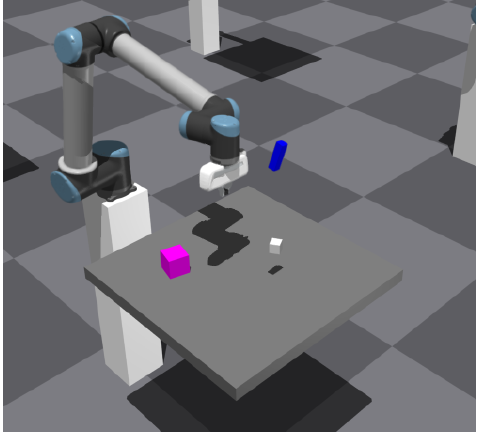
Figure 1. A sub-environment in our Isaac Gym simulation